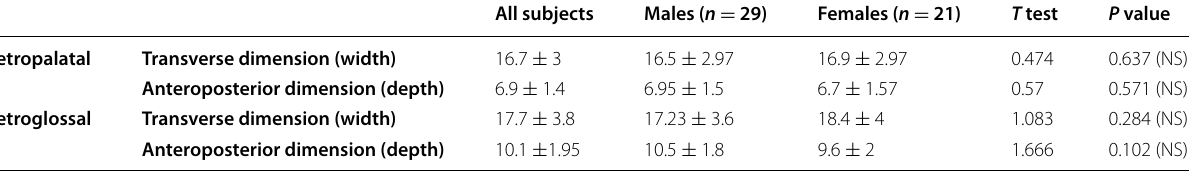
CT Computed tomography, NS Non‑significant